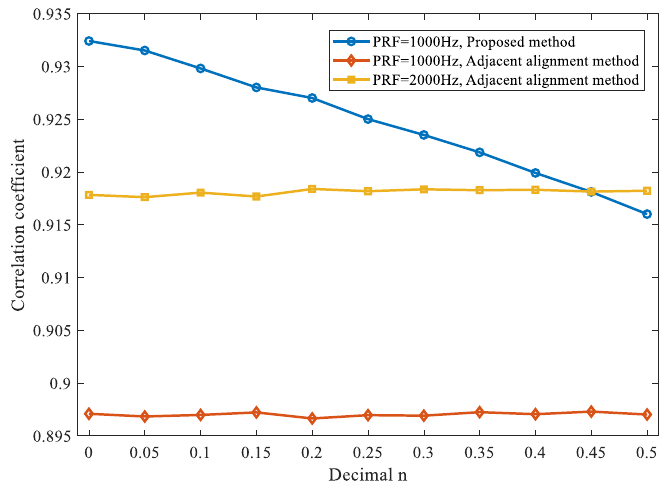
Figure 2. SNR = 20 dB, correlation coefficients versus different rotation periods. The rotation period of the target needs to be known in advance. The rotation period can be estimated by analyzing the correlation between the signals of the spinning